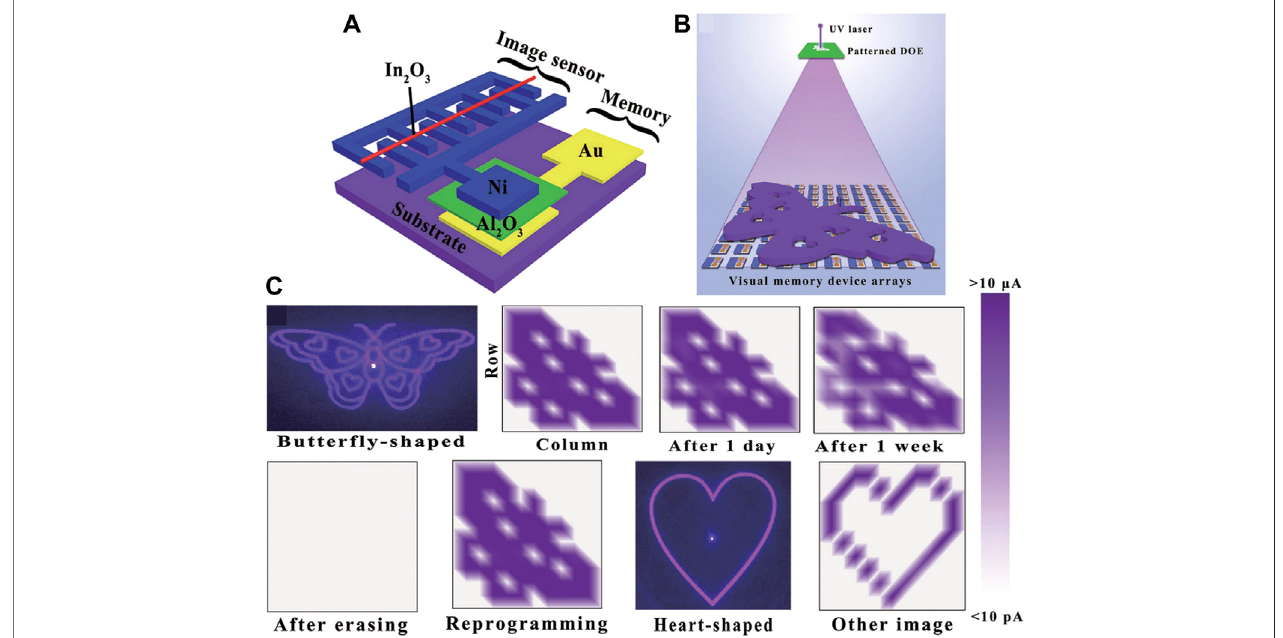
FIGURE 3 | (A) Schematic diagram of the bio-inspired visual memory unit integrated by resistive switching memory device and image sensor. (B) Schematic diagramofthelightdistribution informationproducedbythepatternDOE. (C) InformationStorageBehaviorofFlexibleVisualMemoryDeviceArrays(adaptedfromChen et al., 2018).